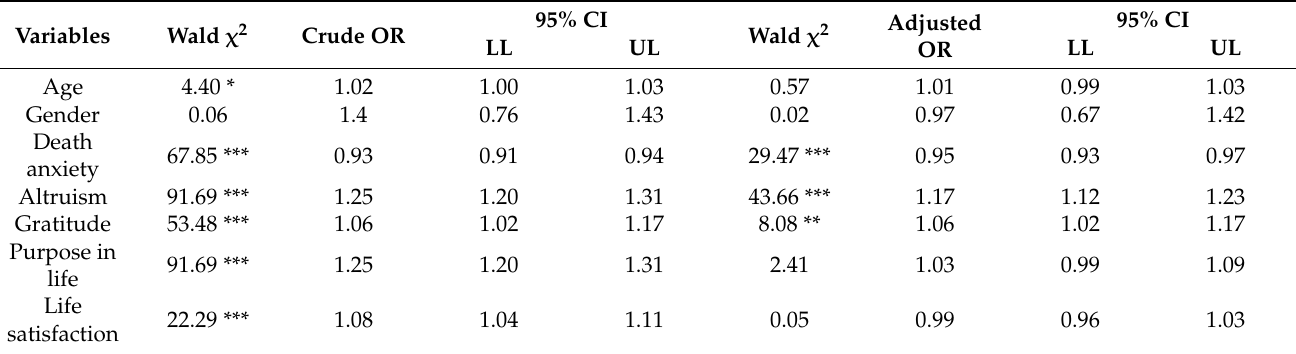
Table 4. Univariate and multivariate logistic regression model